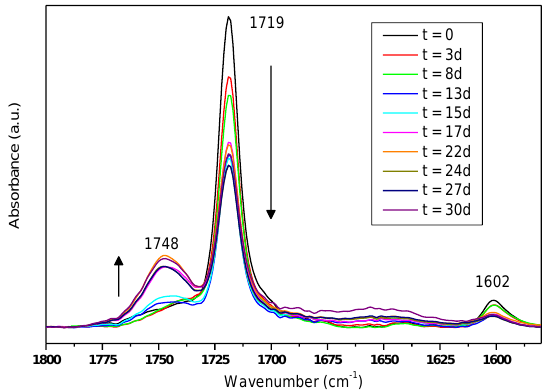
Figure 8. FT-IR spectra of EOC/(CY)_2 collected during the thermo-oxidation process. The spectra were normalized to the band at 720 cm −1 (methylene rocking).